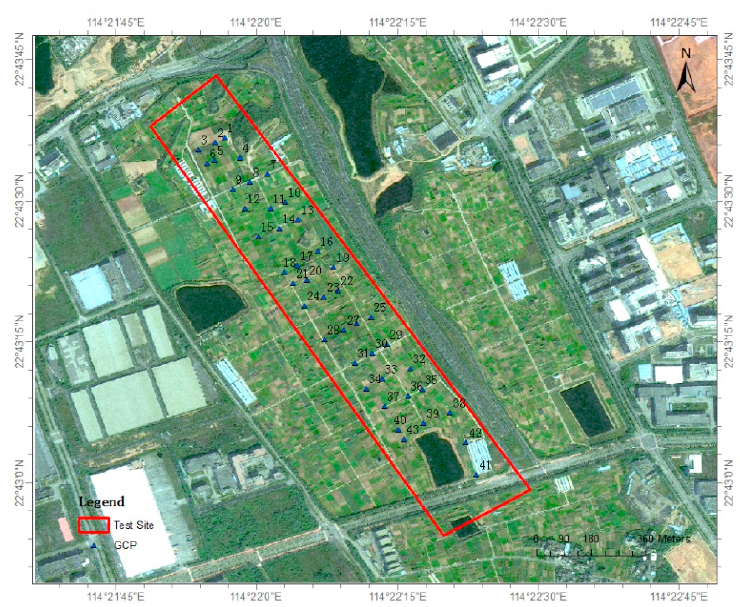
Figure 6. GCPs (Ground Control Points) distribution. The red polygon indicates the approximate test region. GCPs are rendered as blue triangles.